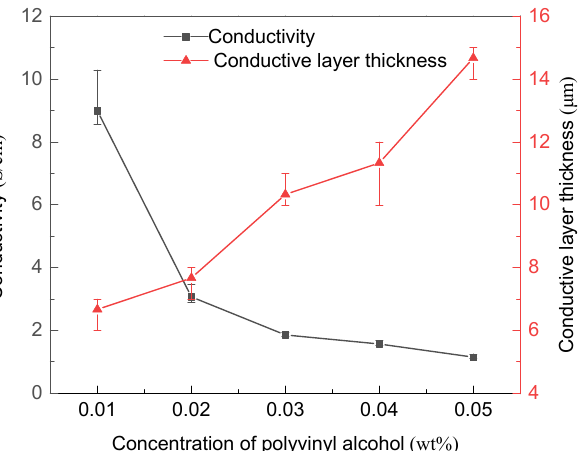
Figure 7. Change of conductivity and conductive layer thickness of MWCNTs/PVDF conductive membrane.